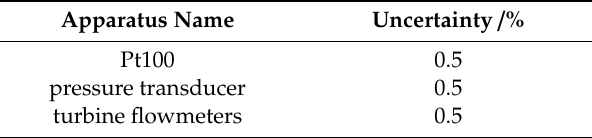
Table 3. Uncertainty of the experimental instruments.